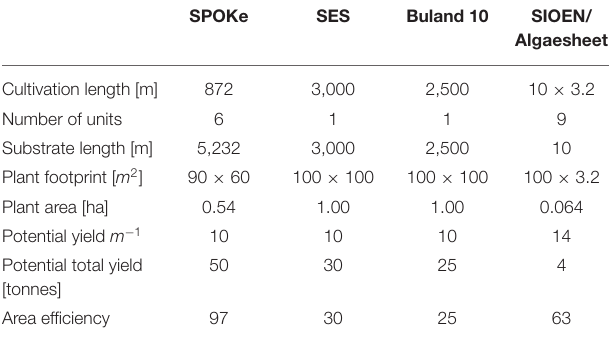
TABLE 3 | Comparison of the proposed concept SPOKe vs. established